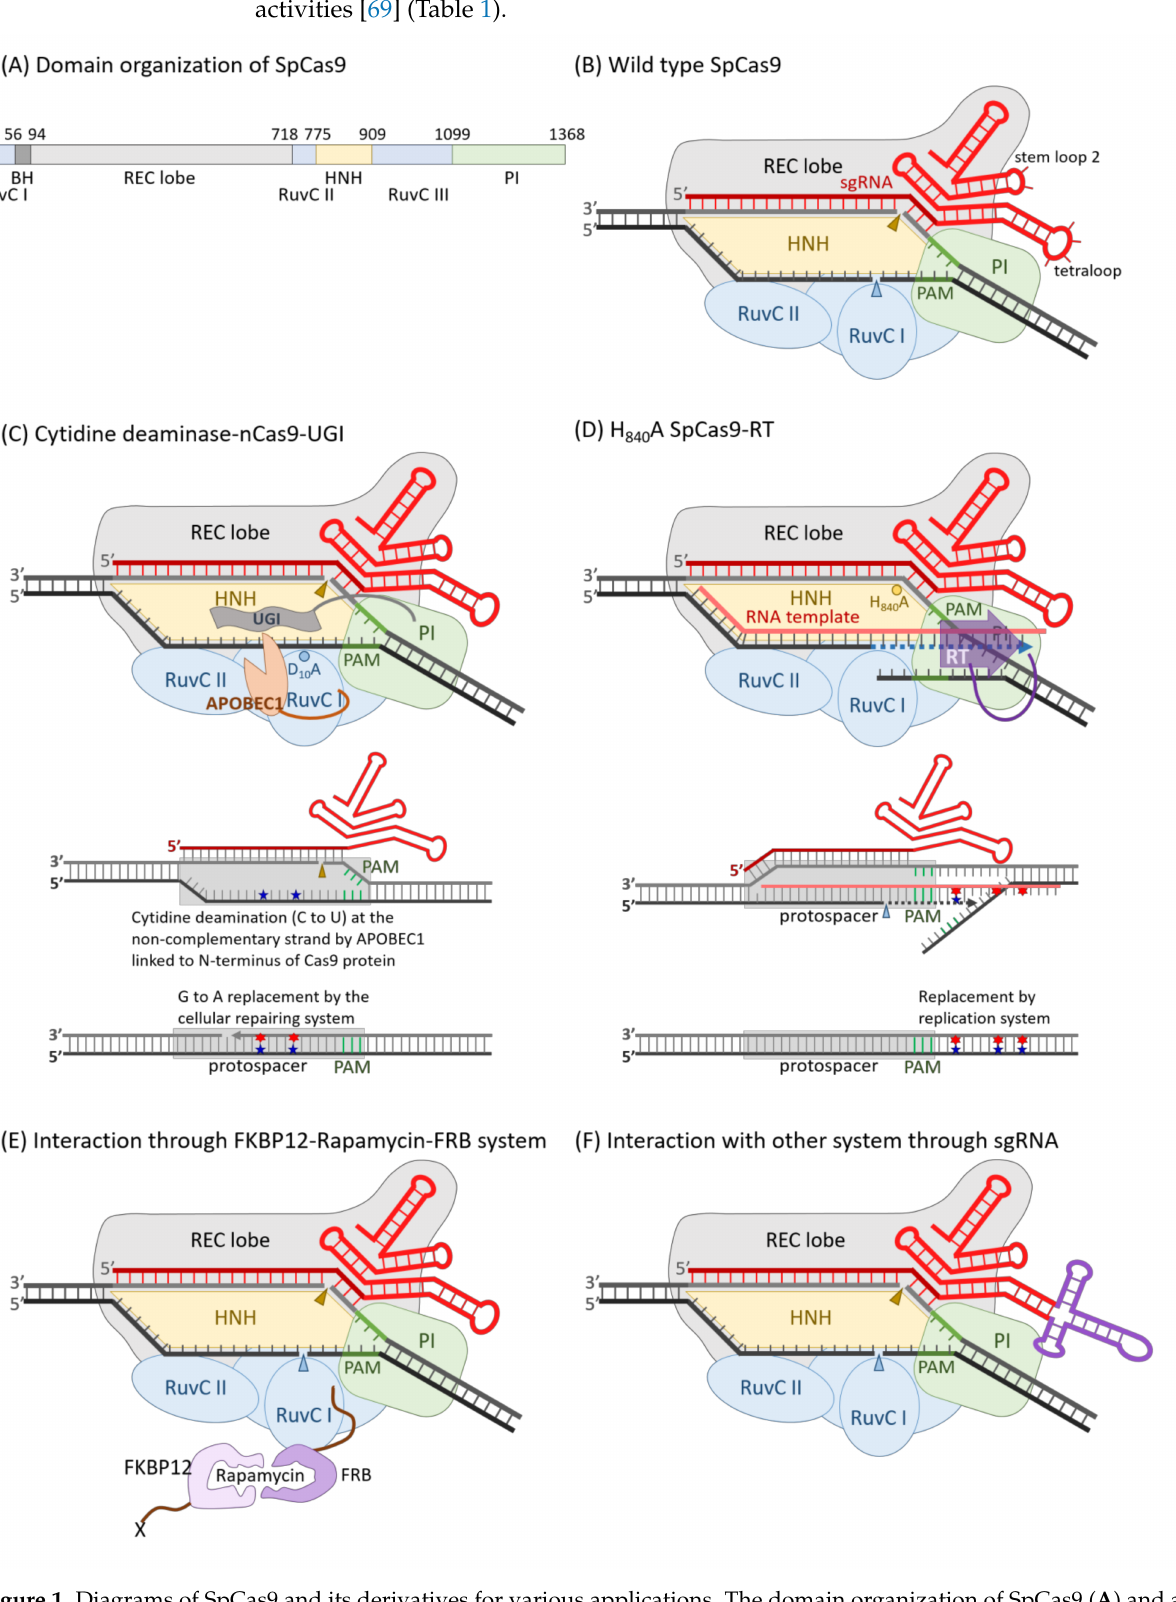
Figure 1. Diagrams of SpCas9 and its derivatives for various applications. The domain organization of SpCas9 ( A ) and a schematic diagram of wild-type SpCas9 associated with a sgRNA ( B ) was illustrated. The non-complementary strand is